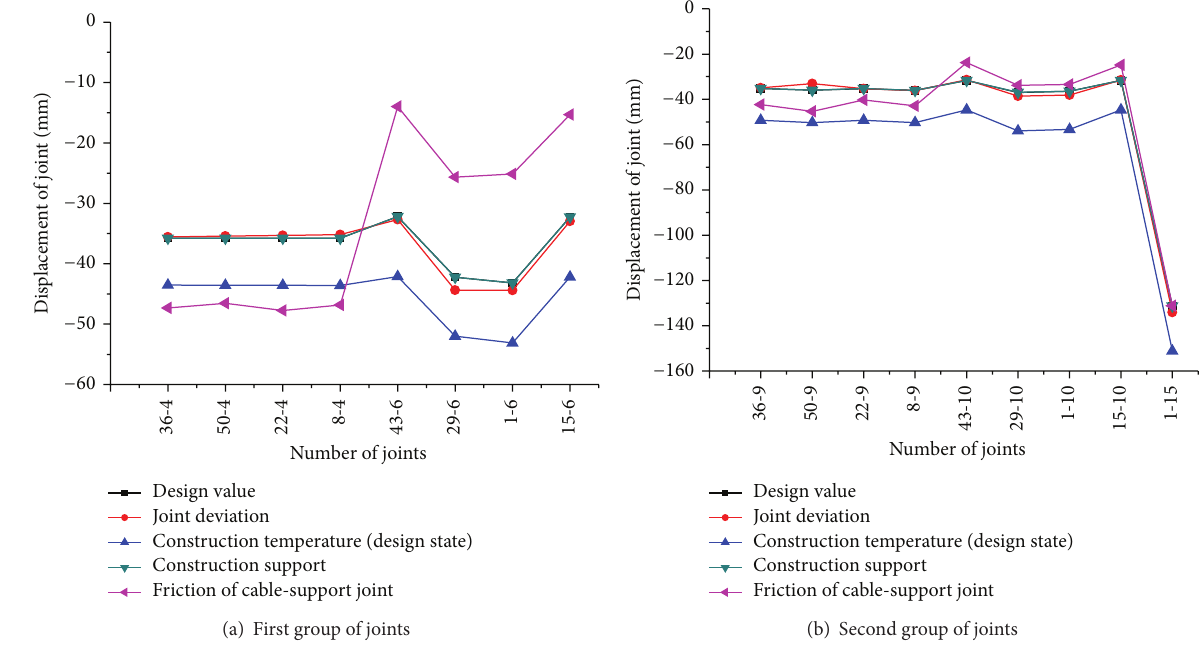
Figure 12: Vertical joint displacement on the upper